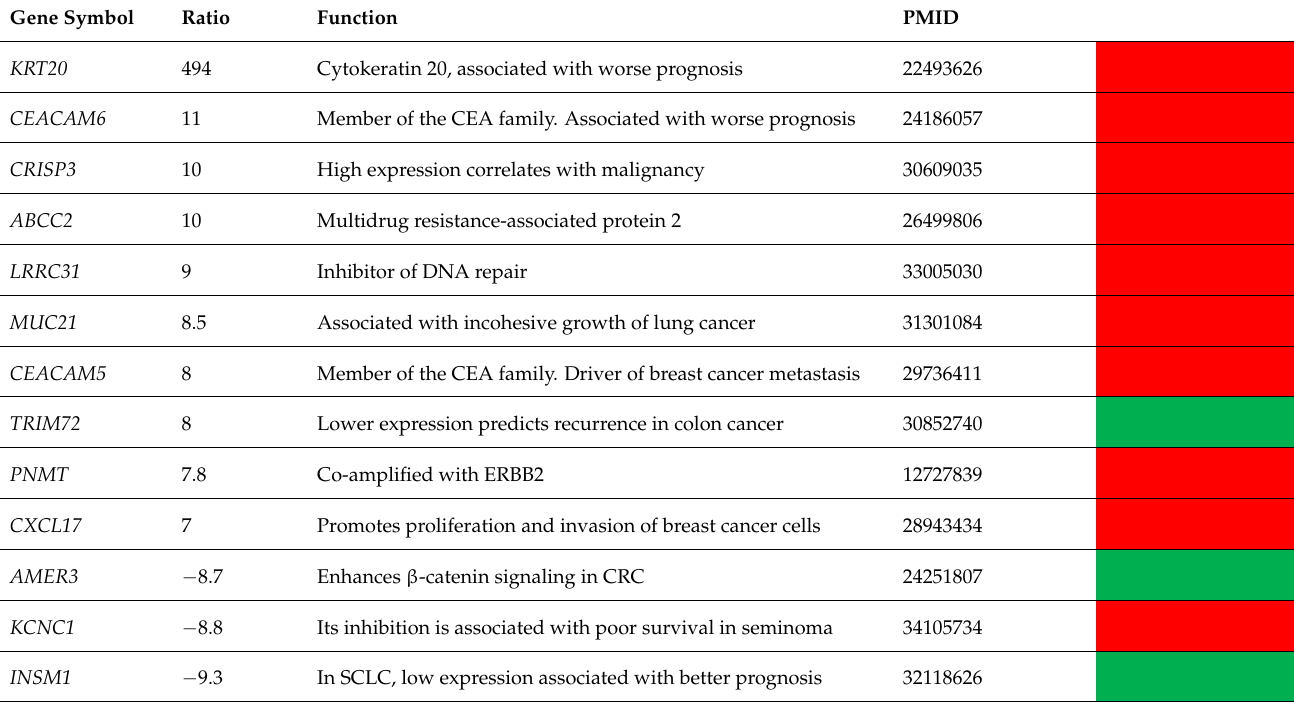
Figure 5. B4GALNT2 mRNA in stomach adenocarcinoma (STAD) and breast cancer (BRCA) TCGA cohorts. In ( A ) and ( C ) plots, the unpaired distribution of B4GALNT2 expression in normal tissue and cancer samples of stomach ( A ) and breast ( C ) cancer patients is reported. In ( B ) and ( D ) graphs, B4GALNT2 distribution in paired normal and tumor tissues of stomach ( B ) and breast ( D ) cancer patients is reported. Stomach: 35 normal and 415 tumor samples; breast: 107 normal and 1100 cancer patients. Statistical analysis conducted by the Mann–Whitney test in A and C and by the Wilcoxon test in ( B ) and ( D ). ( E ): Kaplan–Meier survival curves of patients belonging to the groups of high expressers (15th upper percentile, red) or no expressers (15th lower percentile, blue) of mRNA B4GALNT2 as deduced from the Oncolnc.org website. Table 1. Cancer-relevant genes up- or downregulated in HBE